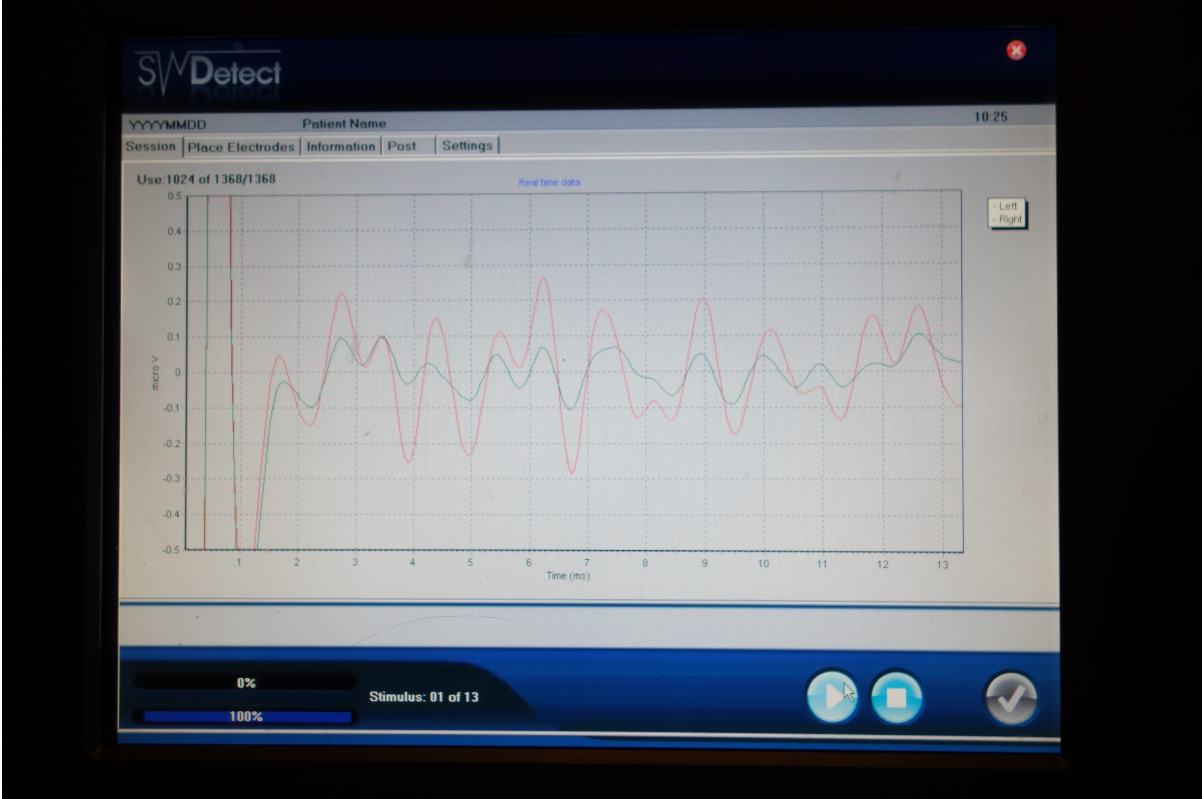
Figure 2. Illustrative photo of equipment used, demonstrating recorded